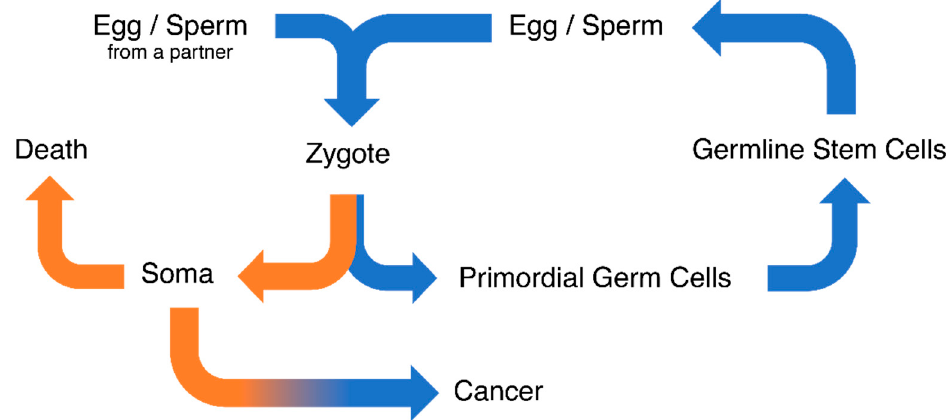
Figure 6. The soma-to-germline oncogenic model: processes related to the human life cycle and cancer development are closely related. Orange: somatic properties. Blue: germline properties.